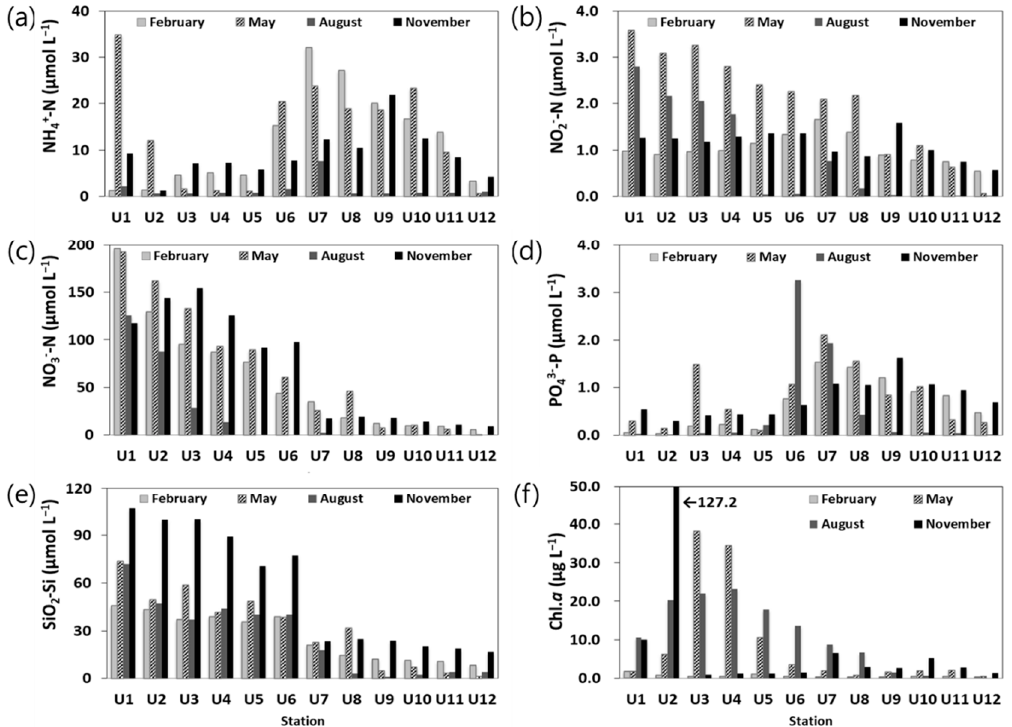
Figure 6. Spatio temporal distributions of nutrients in the Taehwa River estuary in Korea. ( a ) Ammonium, ( b ) nitrite, ( c ) nitrate, ( d ) phosphate, ( e ) silicate and ( f ) chlorophyll a . 3.2.4. Chl. a Chl. a concentrations were in the 0.24–127.20 μ g L − 1 range (average: 8.68 μ g L − 1 ) in the surface water and were in the 0.29–2.31 μ g L − 1 range (average: 1.30 μ g L − 1 ) in the bottom water (Figure 6f). Seasonally, chl. a concentrations were low in February, in the 0.24–1.75 μ g L − 1 range (average: 0.57 ± 0.42 μ g L − 1 ). Chl. a concentrations were in the 0.46–38.22 μ g L − 1 range (average: 8.62 ± 12.72 μ g L − 1 ) in May, with higher values at U3 and U4 because of the algal bloom, i.e., 38.22 μ g L − 1 and 34.52 μ g L − 1 , respectively. Chl. a concentrations were in the 0.64–23.14 μ g L − 1 range (average: 12.51±7.81 μ g L − 1 ) in August. Chl. a concentrations were in the 0.95–127.20 μ g L − 1 range (average: 13.64±34.34 μ g L − 1 ) in November and the highest value was 127.20 μ g L − 1 at U2. As mentioned in the Introduction, non- toxic algal blooms dominated by Cryptomonads occur in the upper estuary (U2–U4) during the dry seasons (November–May) in the Taehwa estuary [24–26]. We also observed an algal bloom in a small area in November; therefore, the chl. a concentrations were high in that area.